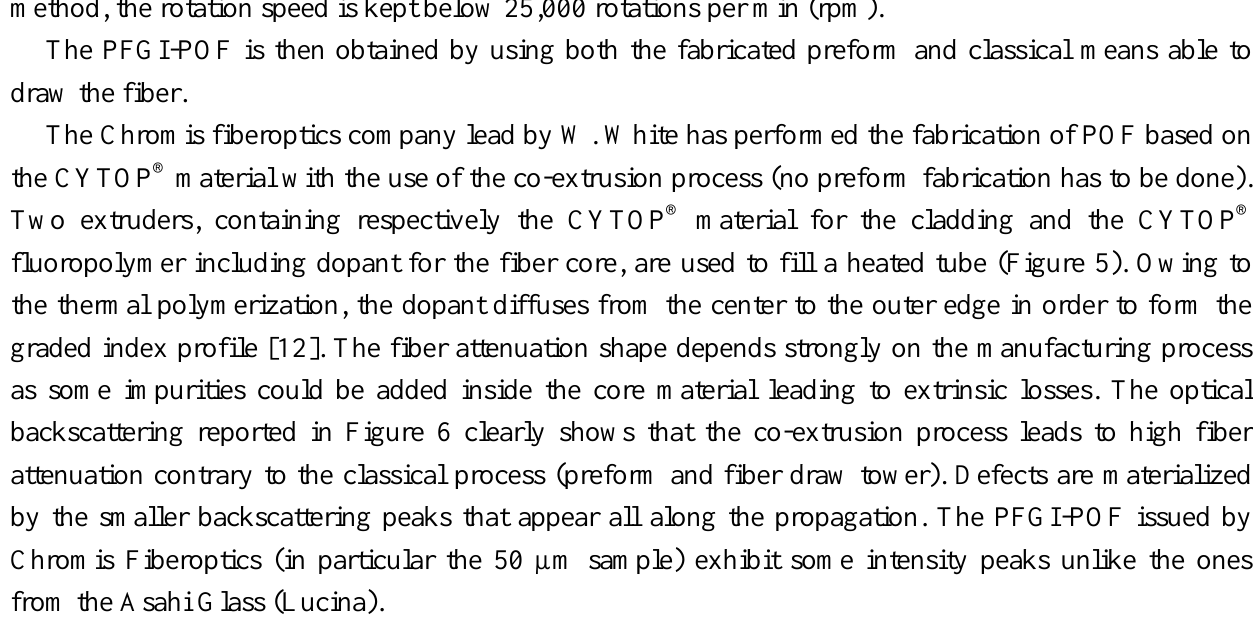
Figure 5. Manufacturing processes used by Chromis Fiberoptics (co-extrusion process [12]).